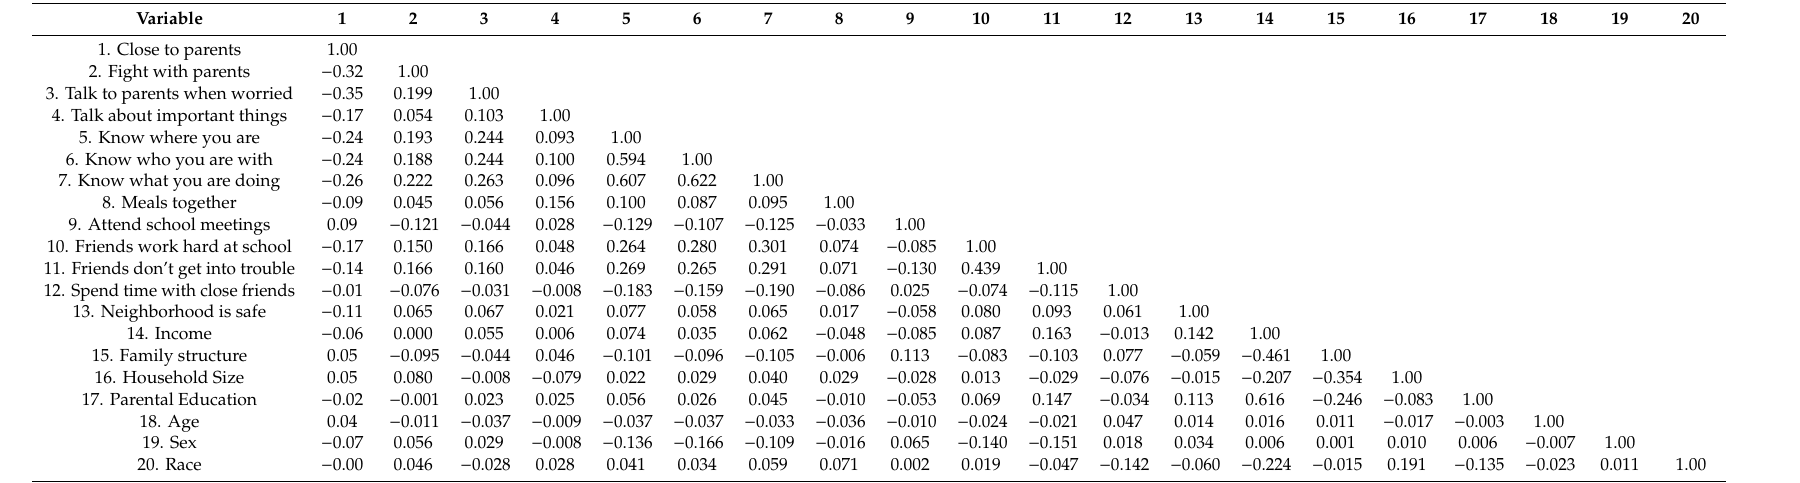
Table 2. Correlations among Explanatory and Control Variables Included in